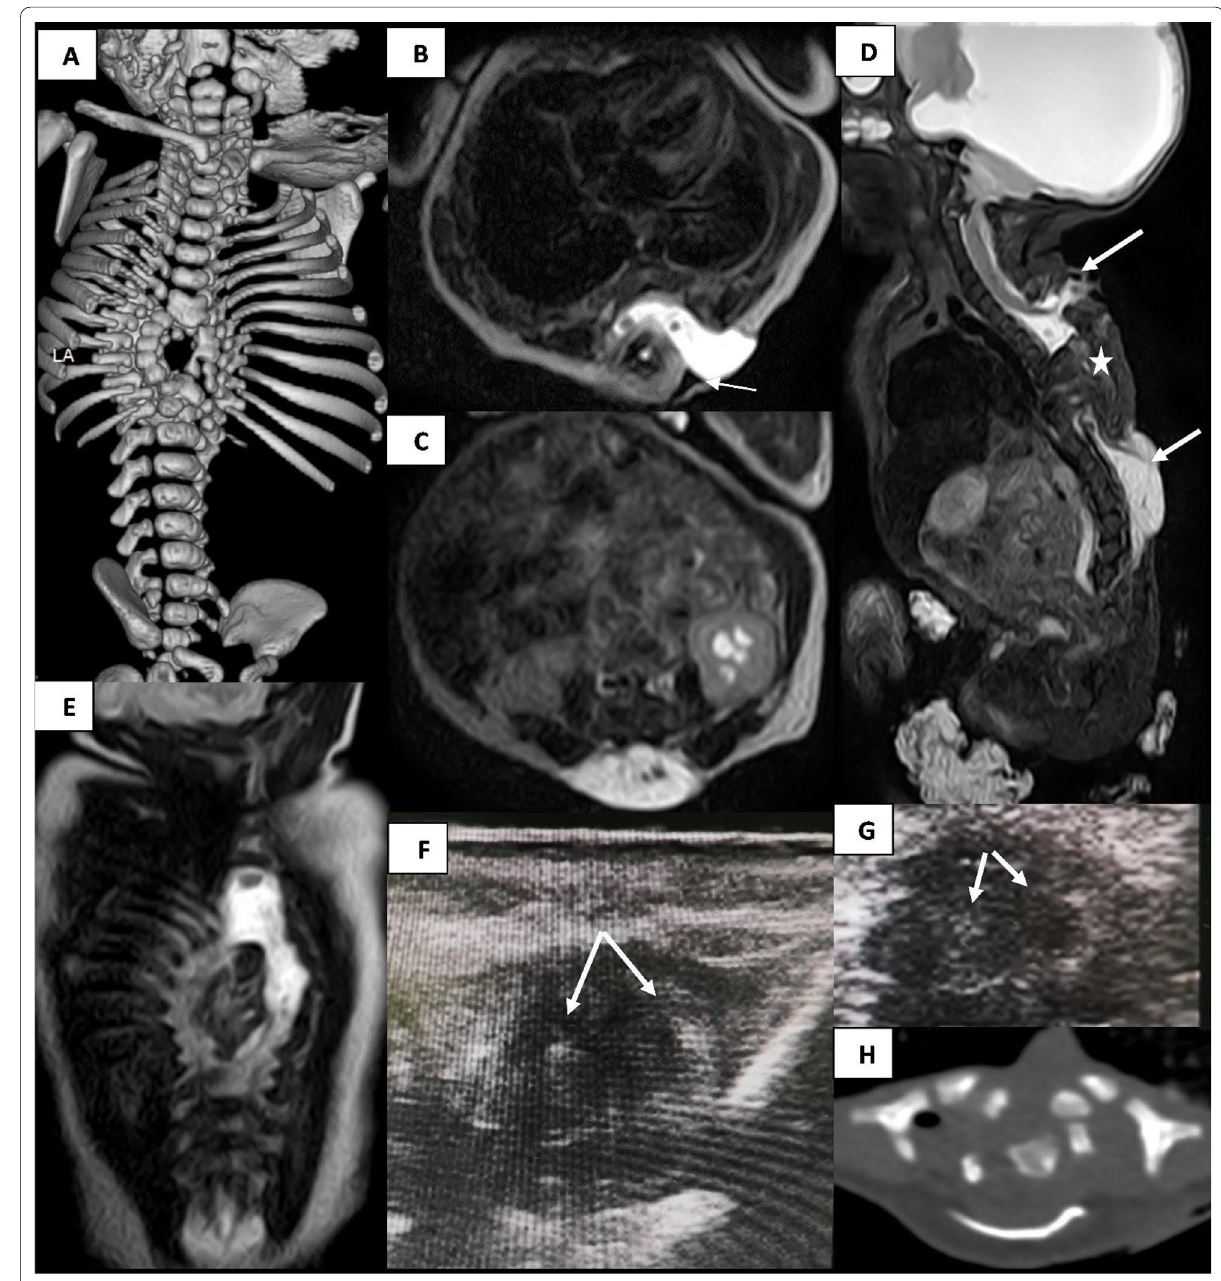
Fig. 4 Twenty-day-old female infant presented with multiple back masses, 2 cystic and one solid at both dorsal and lumbar levels. A 3D reconstruction image of bony spine showing multilevel segmentation anomalies with complete splitting of lower 6 thoracic vertebrae into 2 separate spinal canals. B Axial T2WI at upper dorsal level showing 2 hemicords herniating into two sacs in keeping with hemi-myelomeningoceles, on the left side shows focal rupture (white arrow). C Axial T2WI at upper lumbar level showing another intact myelomeningocele containing two hemi cords, note left sided hydronephrosis. D Sagittal fat suppressed image of whole spine showing upper dorsal and lumbar myelomeningoceles (white arrows) as well as lower dorsal heterogenous fat containing lesion (white star), note associated hydrocephalus. E Coronal T2WI showing segmental lower dorsal splitted bony elements with heterogenous mass in-between containing both fatty and bony elements histopathologically proven to be teratoma. F , G Bed side axial USG images showing two hemicords within single dural sheath (white arrows). H Axial CT image bone window at lower dorsal level showing splitted spinal canal. Type of spinal dysraphism: Split notochord (Diastematomyelia) with